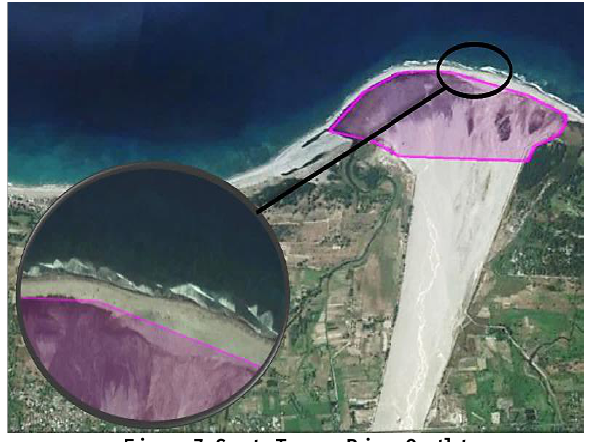
Figure 7. Santo Tomas River